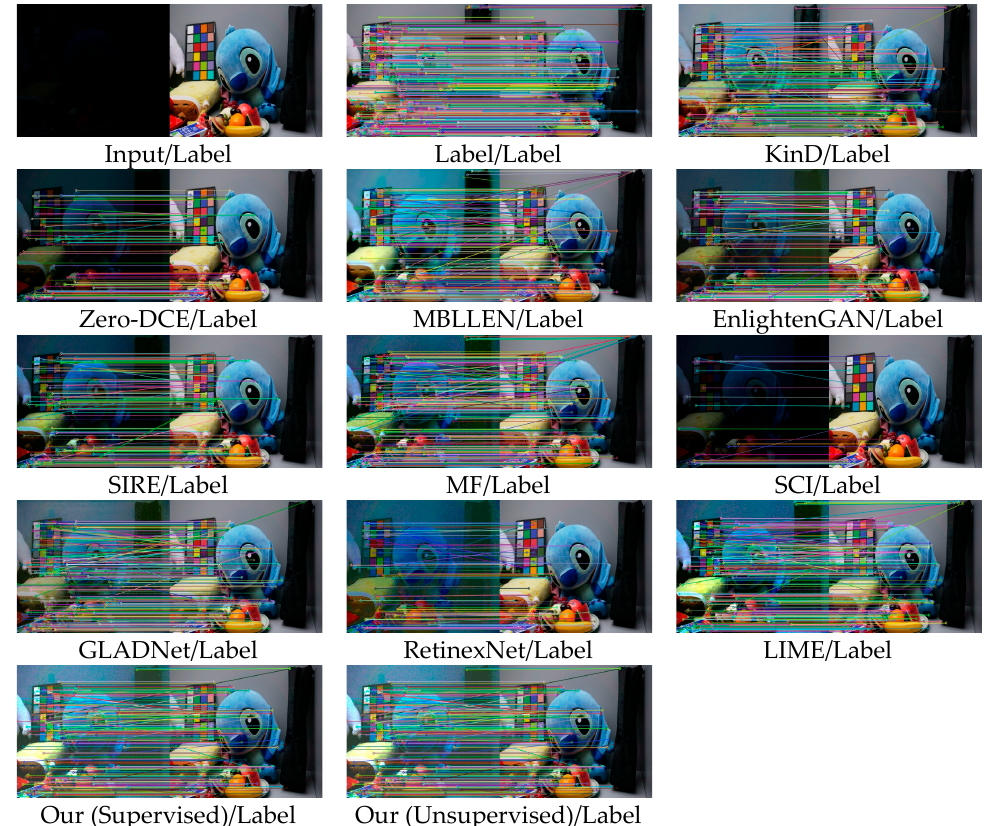
Figure 11. Visualization of image matching results enhanced by different algorithms. Table 3. Comparison of image matching results enhanced by different algorithms.